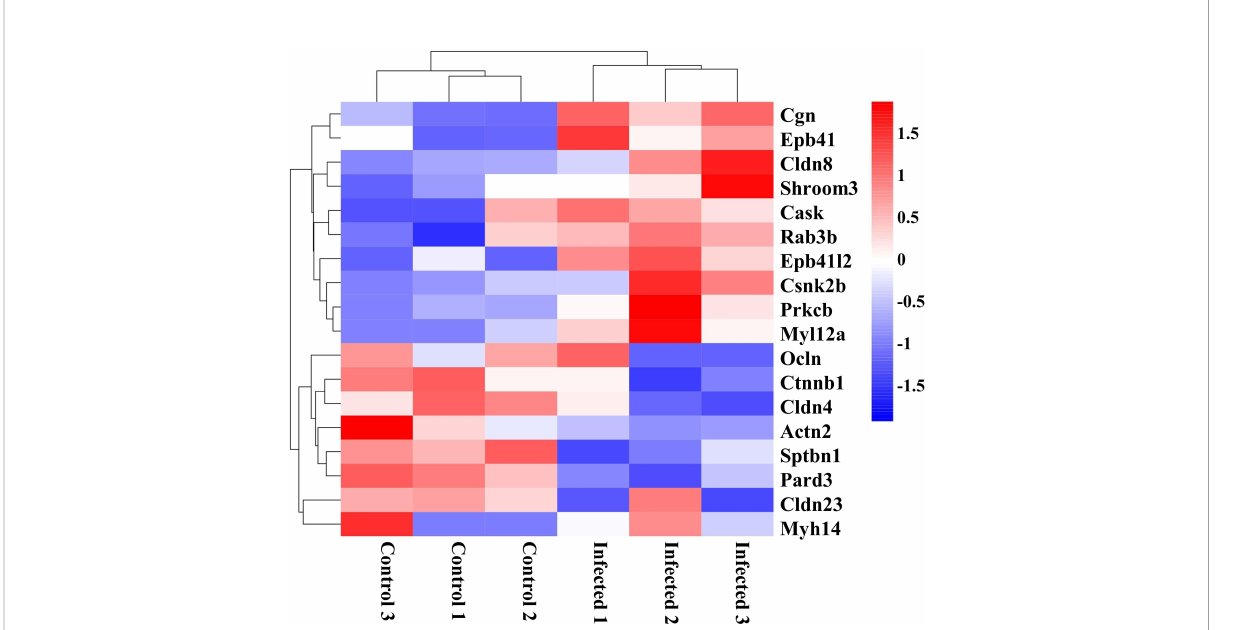
FIGURE 5 Clustering heatmap of differentially expressed genes related to tight junction organization in the colon post the protoscoleces of Echinococcus granulosus infection. Hierarchical clustering was performed as a heatmap, which shows distribution of the differential mRNA level between the Control and Infected groups. The color shows the degree to which the gene is expressed with range between -1.5 and 1.5. Red color means the upregulated mRNAs and blue color means the downregulated